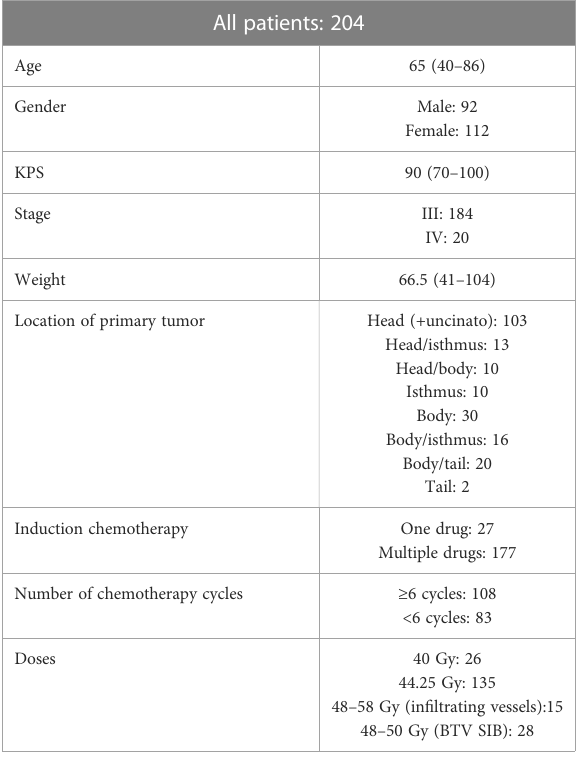
TABLE 1 Main characteristics of considered patients. All patients: